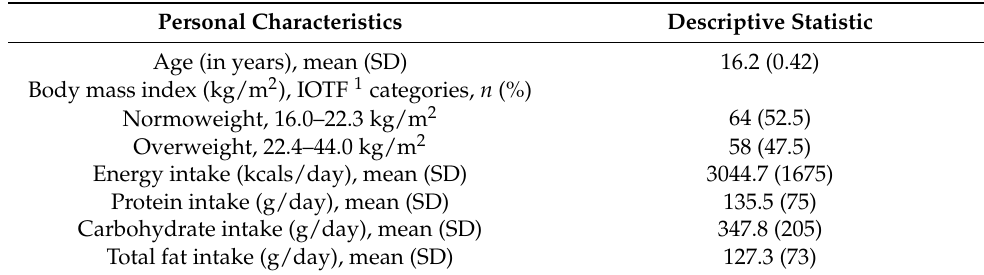
Table 1. Characteristics of INMA-Granada cohort study participants ( n = 122).